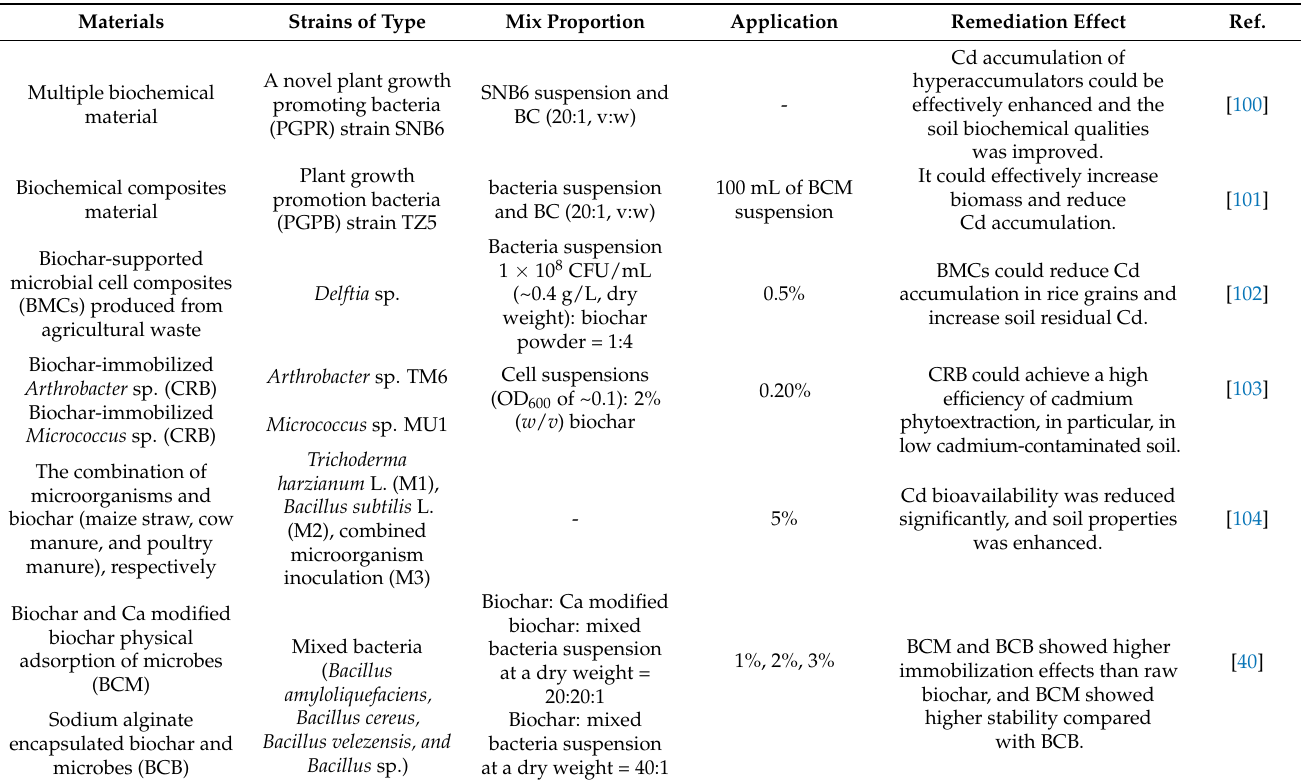
Table 5. Remediation of Cd in soil by using biochar microbial